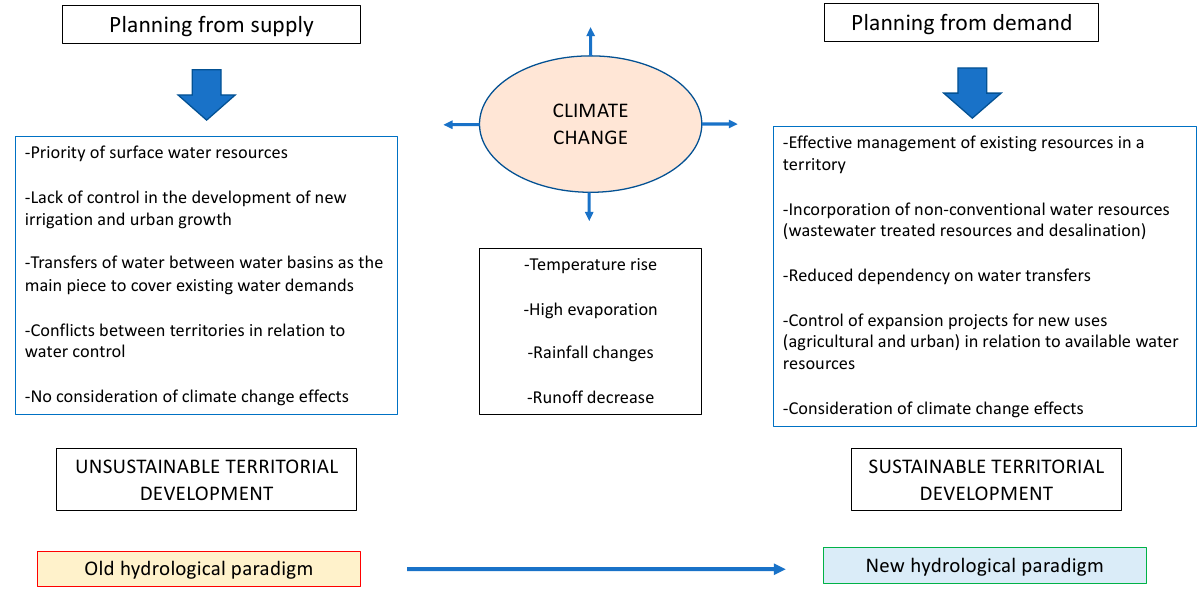
Figure 1. Scheme of the old and new paradigm in water planning in study area. Source: own elabo- ration.